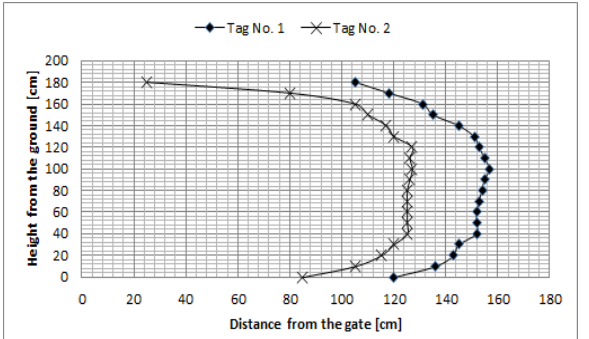
Fig. 2. Characteristics of the maximum distance between a tag and a gate at which a tag is